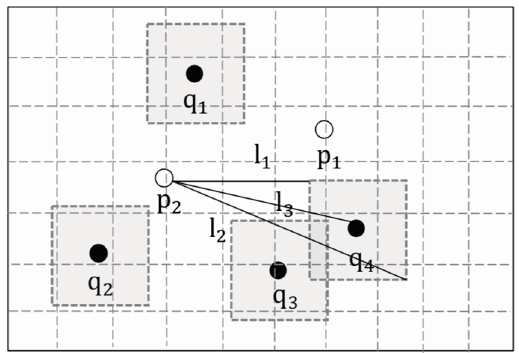
Figure 7. Secure areas and dominated distances.